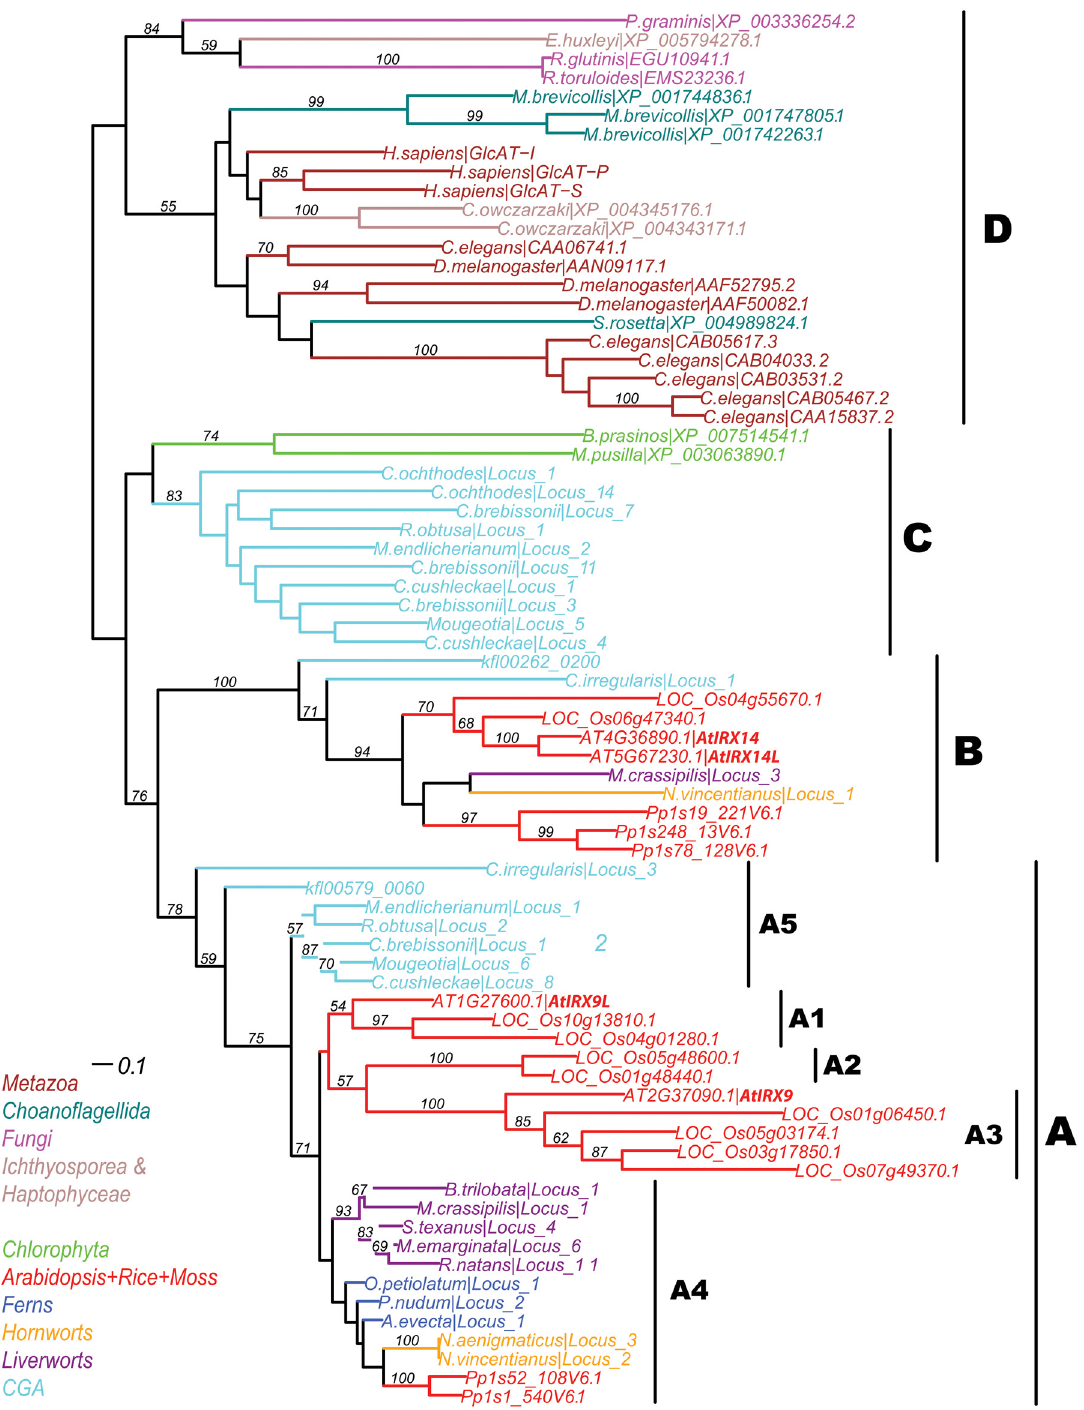
Fig 2. Phylogeny of 74 GT43 proteins. 21 plant proteins are from the PlantCAZyme database, 12 animal proteins are from the CAZy database, 12 early eukaryotic proteins are from Table 1 and 29 early plant transcriptome-derived peptides are from S4 Table. Sequences were aligned using the MAFFT program. Phylogeny was inferred using RAxML program (see Methods). Complete species names are available in S3 Table and S4 Table.